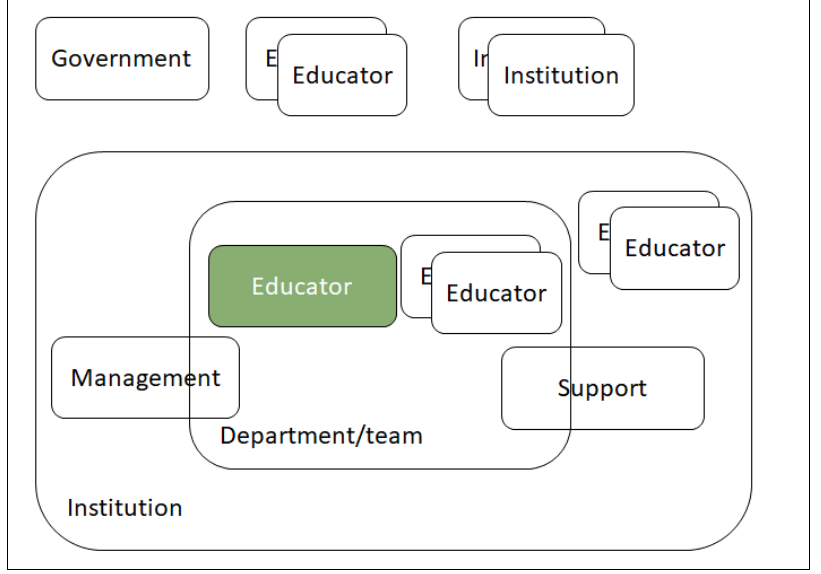
Figure 1. Configuration of an educator in the Dutch public Higher Education